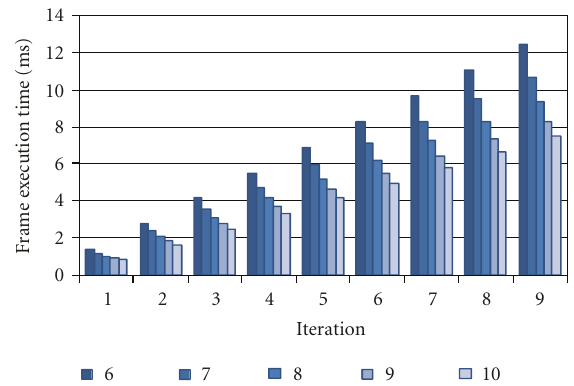
Figure 7: Frame execution time for Caballero with di ff erent CNN sizes, when slicing is